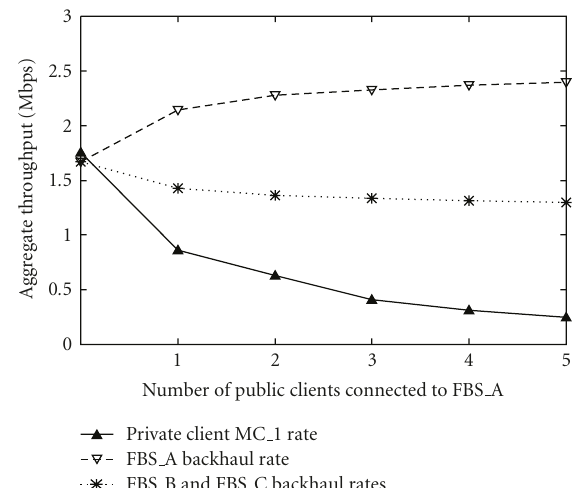
Figure 6: Private mode achievable rate versus backhaul rate. This figure shows the e ff ects of allowing public clients to connect to an FBS. It can be seen that the achievable throughput of the private client which owns the FBS decreases as the number of public clients connecting to the FBS increases. It can also be observed that, using our compensation mechanism, the backhaul rate of the a ff ected FBS is increased to compensate for the service to public